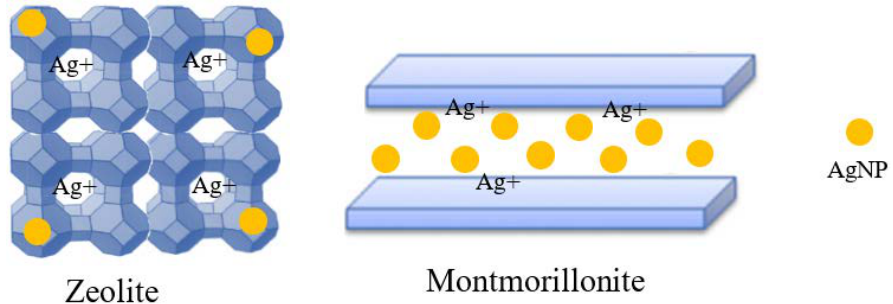
Figure 1. Accommodation of silver ions and nanoparticles on zeolite and montmorillonite.